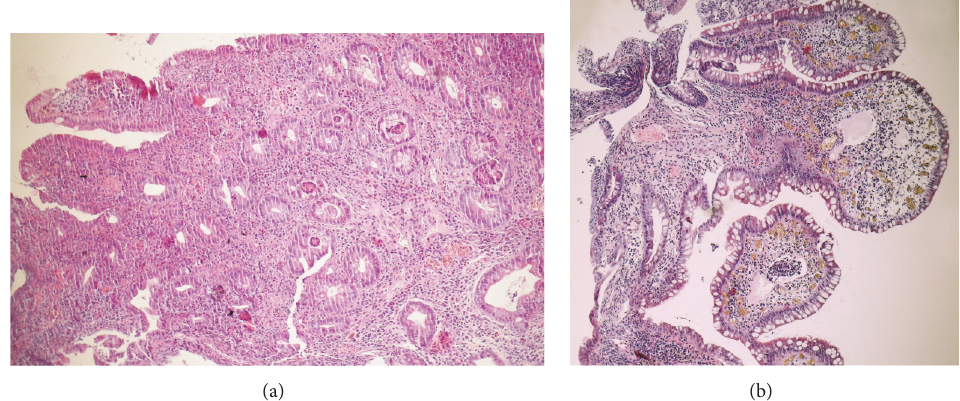
Figure 2: Representative histology sections of the ileum. The biopsy specimen before the treatment (a) reveals villous architecturaldistortion and a combination of acute and chronic abundant inflammation of the lamina propria. The inflammation consists of neutrophils, plasma cells, and lymphocytes. After 5 months of vedolizumab therapy (b), stromal oedema, and hyperaemia only a few lymphocytes and plasma cells in the lamina propria are visible.